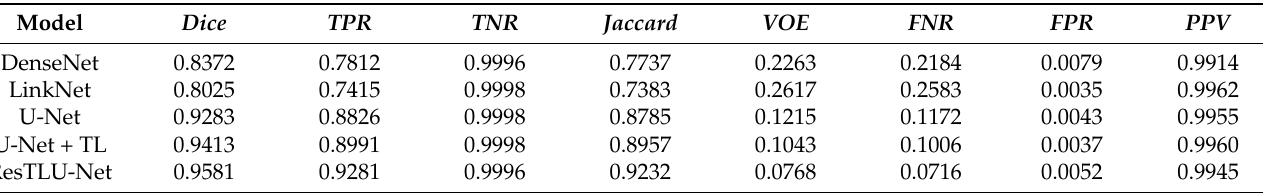
Table 1. Evaluation results of five different